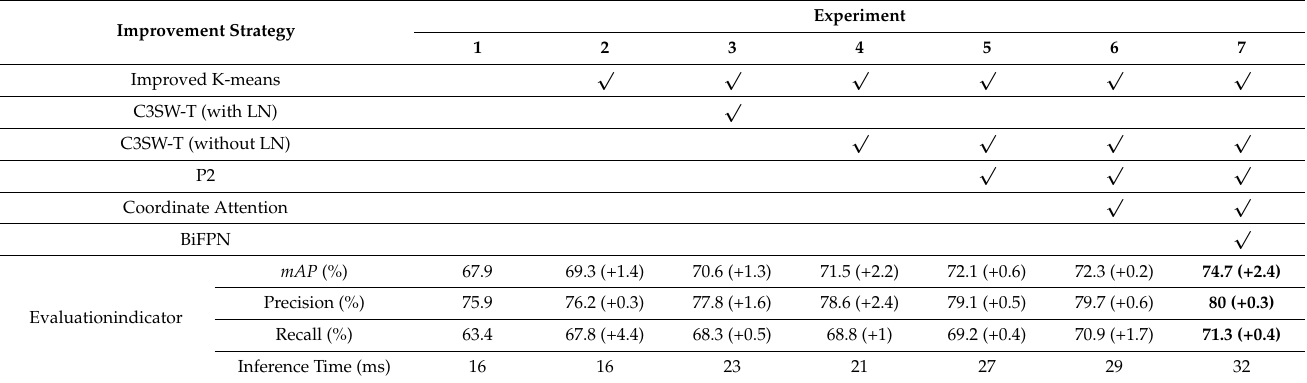
Table 3. Test results after different improvement strategies are